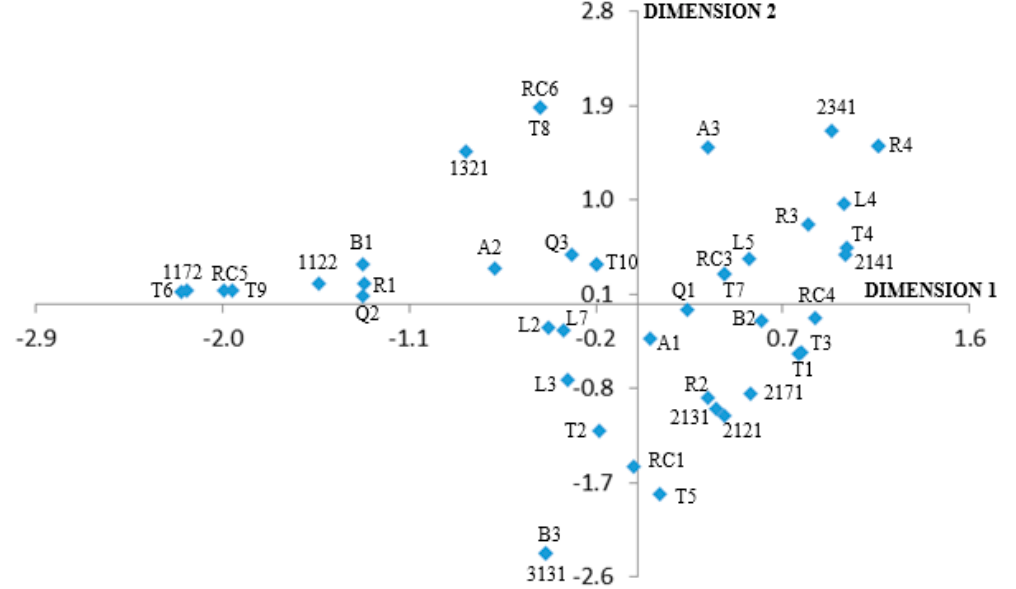
Figure 2. Factorial plane of the multiple correspondence analysis (the nomenclature of the categories is shown in Table B1, see Appendix B).